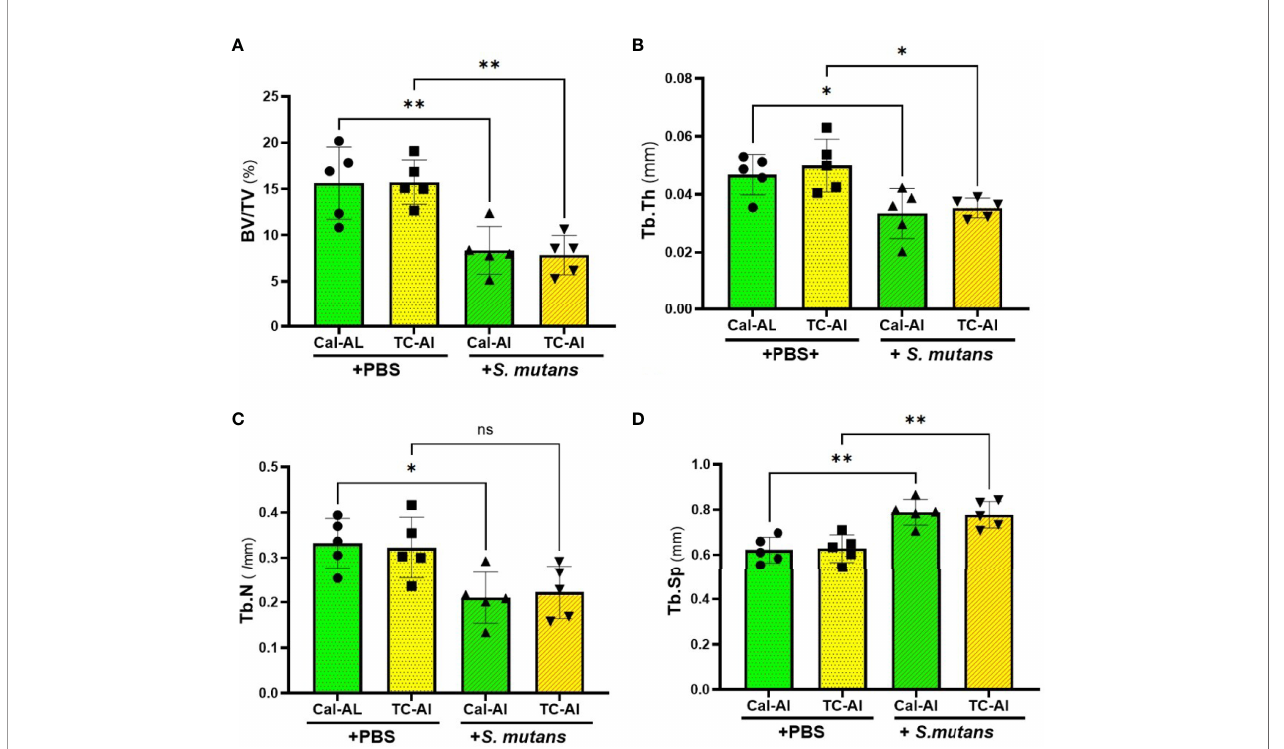
FIGURE 6 | S. mutans inoculation decreased structural parameters of bone. Quantitative analyses of the bone structural parameters of the distal femur after seven days of intravenous injection of PBS or S. mutans inoculation. (A) The ratio of bone volume (BV) to tissue volume (TV), (B) Trabecular thickness (Tb.Th), (C) Trabecular number (Tb.N), (D) Trabecular separation (Tb.Sp). Cal-Al, mice received double injections of calcein and alizarin; TC-Al, mice received double injections of tetracycline and alizarin; +PBS, intravenously PBS-injected groups; +S. mutans , intravenously S. mutans -inoculated groups. The variance of data was analyzed by the Levene test. The comparison between groups was analyzed by the ANOVA and Tukey HSD test. Values are expressed as the mean ± SD, *p < 0.05, **p < 0.01, ns, no statistically signi fi cant difference (p >